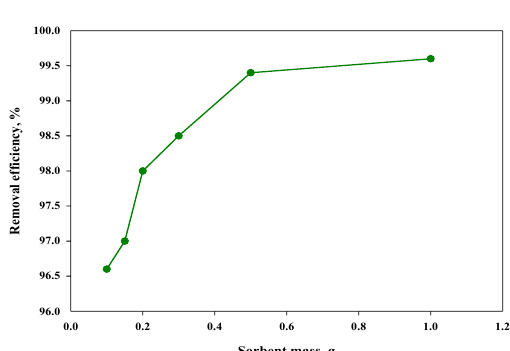
Fig. 4. Effect of sorbent mass on the adsorption of reac- tive blue 50 onto zero valent iron (C 0 =150 mg · L -1 , pH=6.0, room temperature)